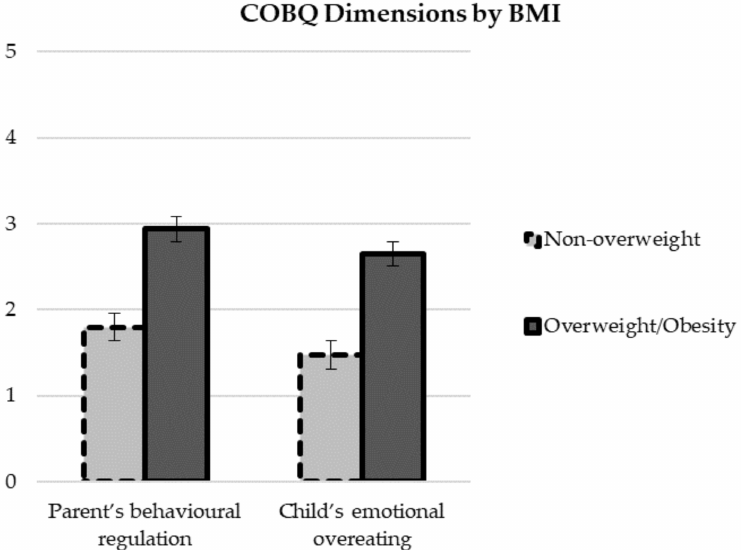
Figure 1. Differences in the Childhood Obesogenic Behaviours’ Questionnaire dimensions between children who are non-overweight and overweight/obese. No significant differences were found in the two scales considered of the Childhood Obesogenic Behaviours’ Questionnaire (Parent’s Behavioural Regulation and Child Emotional Overeating) between the two age groups and between boys and girls. Means for Parent’s Behavioural Regulation were 2.45 ( SD = 0.99) for 4-year-olds and 2.41 ( SD = 0.93) for 7-year-olds, and for Child Emotional Overeating means were 2.06 (0.96) for 4-year-olds and 2.22 (0.93) for 7-year-olds. As to gender, in the first variable means were 2.51 (0.90) for boys and 2.35 (1.02) for girls, and in Child Emotional Overeating means were 2.22 (0.95) for boys and 2.05 (0.95) for